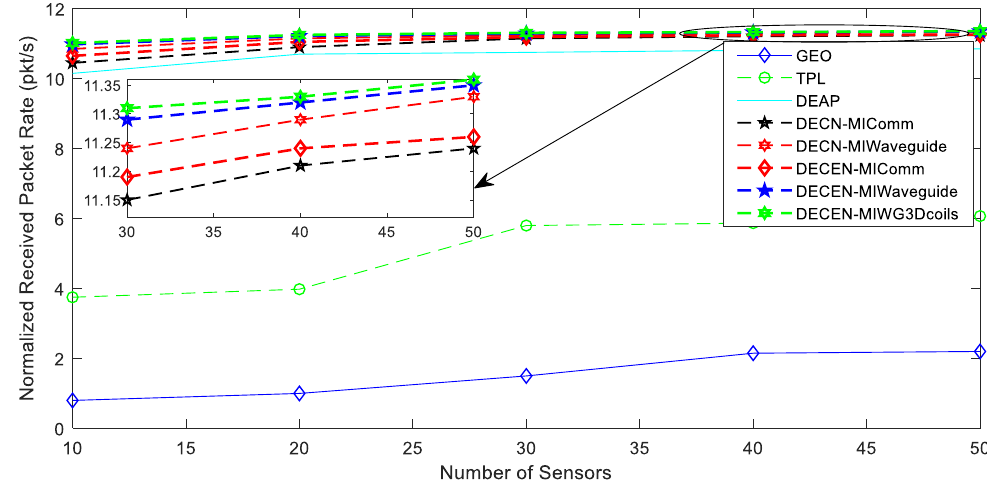
Figure 10. Comparison graph for received packet rate with the varying number of sensors.